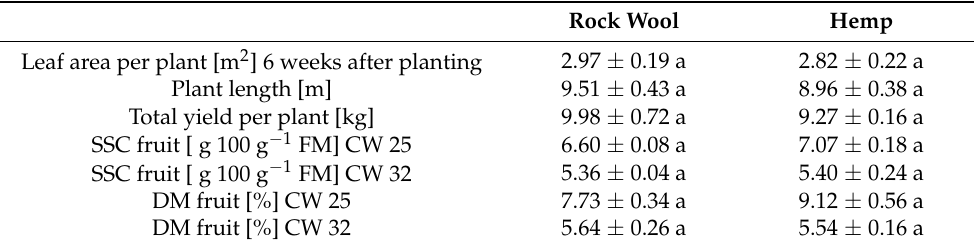
Table 4. Effects of different growing media on tomato plant growth and yield during and at the end of cultivation.